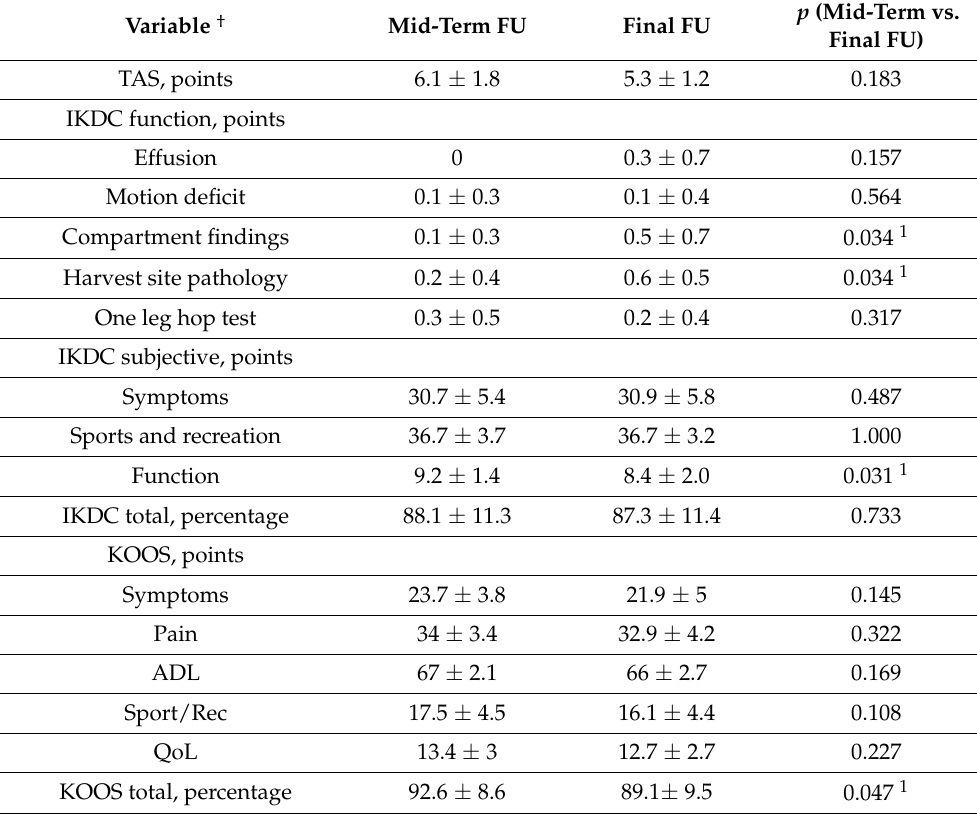
Table 2. Clinical and radiographic outcome at mid-term and final